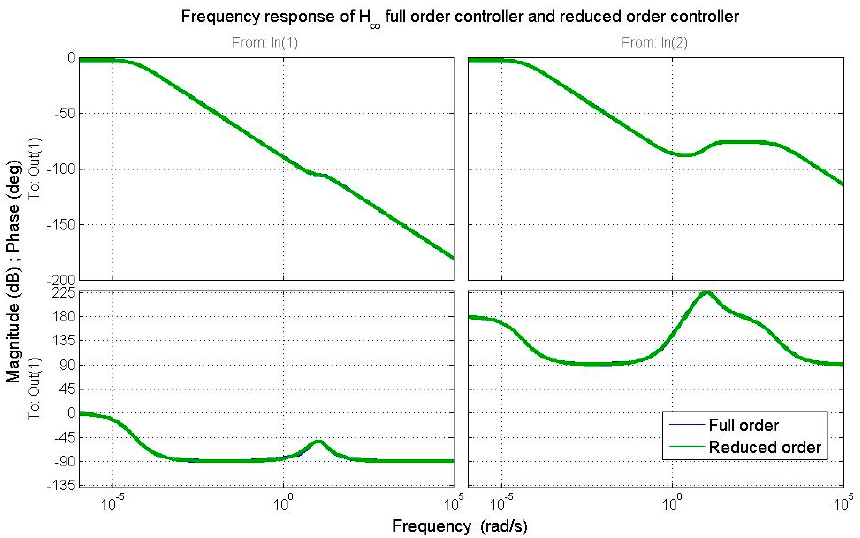
Figure 19. Frequency response of H ∞ full order controller and reduced order controller. Figure 19. Frequency response of (cid:1834) (cid:2998) full order controller and reduced order controller. Figure 19. Frequency response of (cid:1834) (cid:2998) full order controller and reduced order controller.